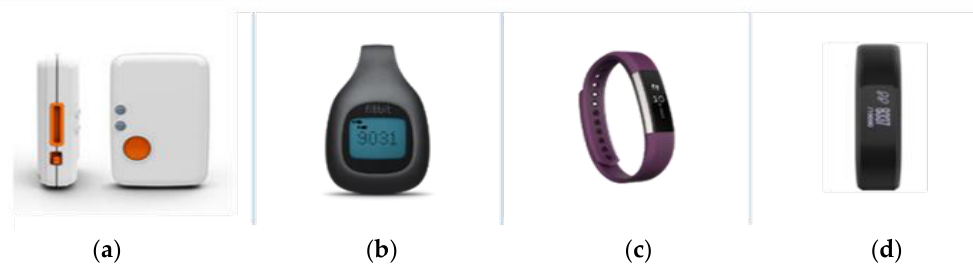
Figure 2. Technological devices used as gold-standard and comparison tools: ( a ) Shimmer3 IMUs, ( b ) Fitbit zip, ( c ) Fitbit Alta and ( d ) Garmin vivo smart HR.